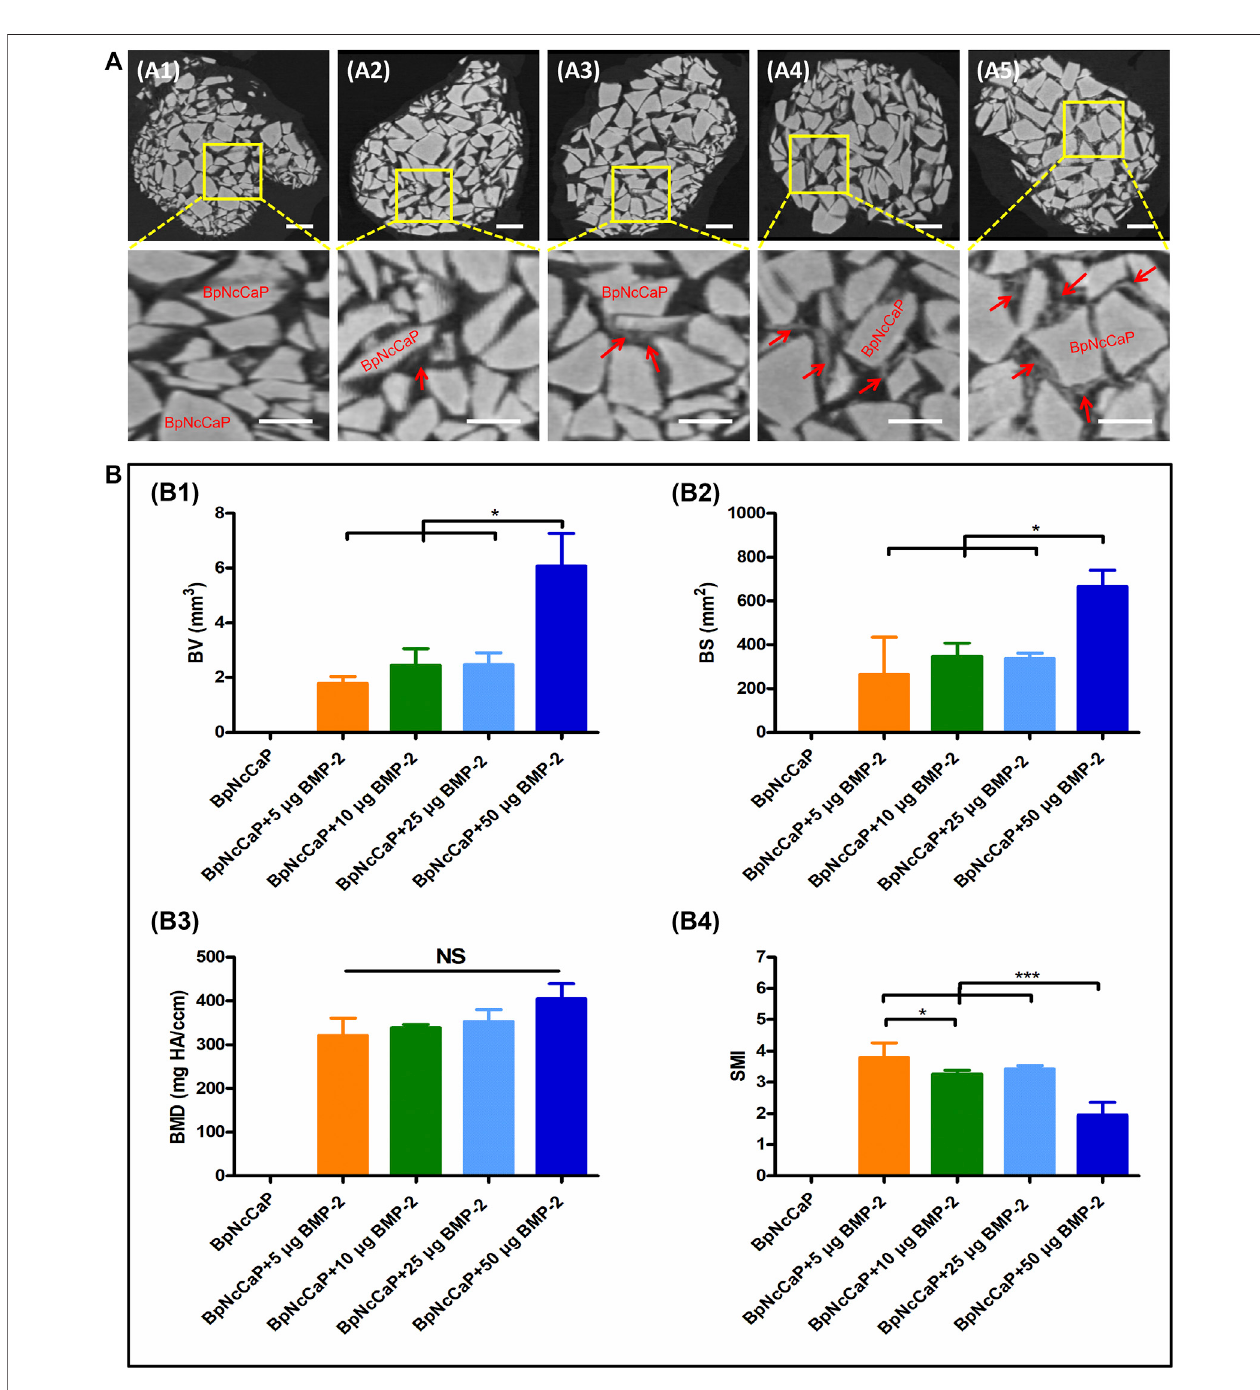
surface area (B2) , bone mineral density (B3) , structure mode index (B4) for BpNcCaPs without or with different amounts (5/10/25/50 μ g) of BMP-2. Data were presented as mean ± SD. Signi fi cant effect of the treatment, * p < 0.05; ** p < 0.01; *** p <